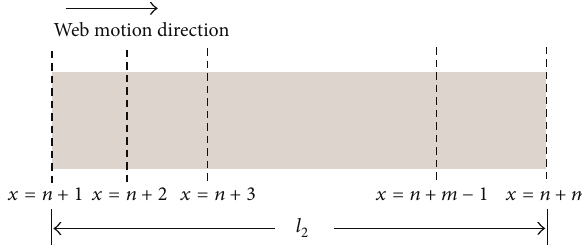
Figure 10: Finite difference grid applied to the web in the second drying